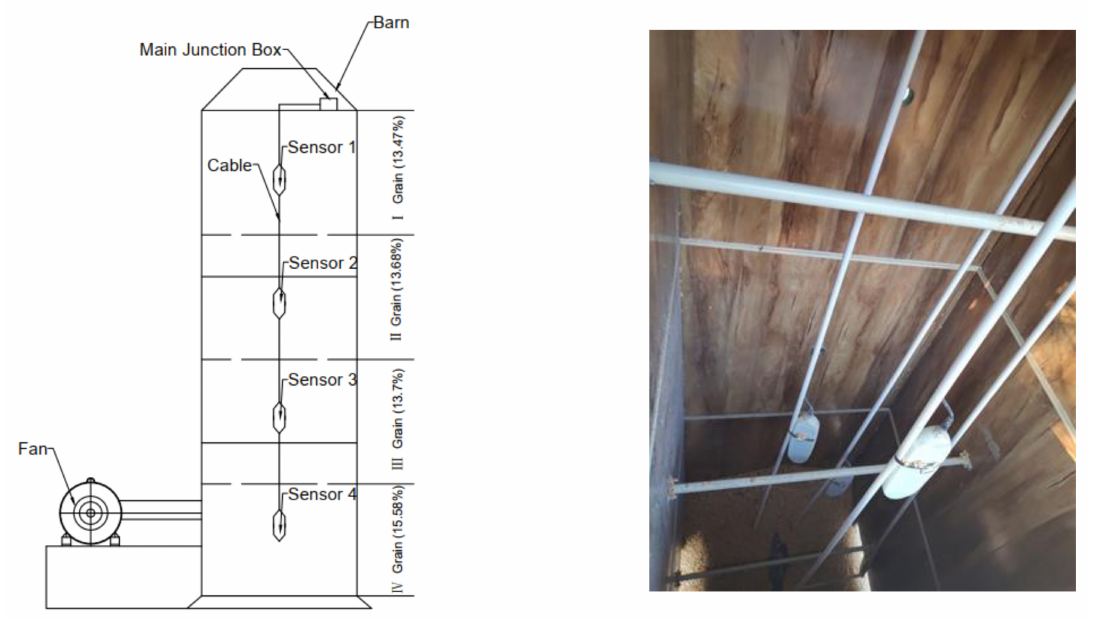
Figure 21. The sensor location layout in the granary and the actual layout in the sensor warehouse. The experiment was conducted from 4 November 2018 to 20 December 2018. The temperature of the granary varied from − 2 to 15 ◦ C, and the humidity varied from 59 to 97 RH%. The experiment was conducted to compare the grain moisture values detected by the four-layer sensor with the actual grain moisture value. As shown in Figure 22, for the first layer, a comparison between the grain moisture value and the actual grain moisture value was made. From 4 to 9 November, the trend of the moisture content detected by the sensor was the same as that of the actual value, and the detection error was ± 0.215%.